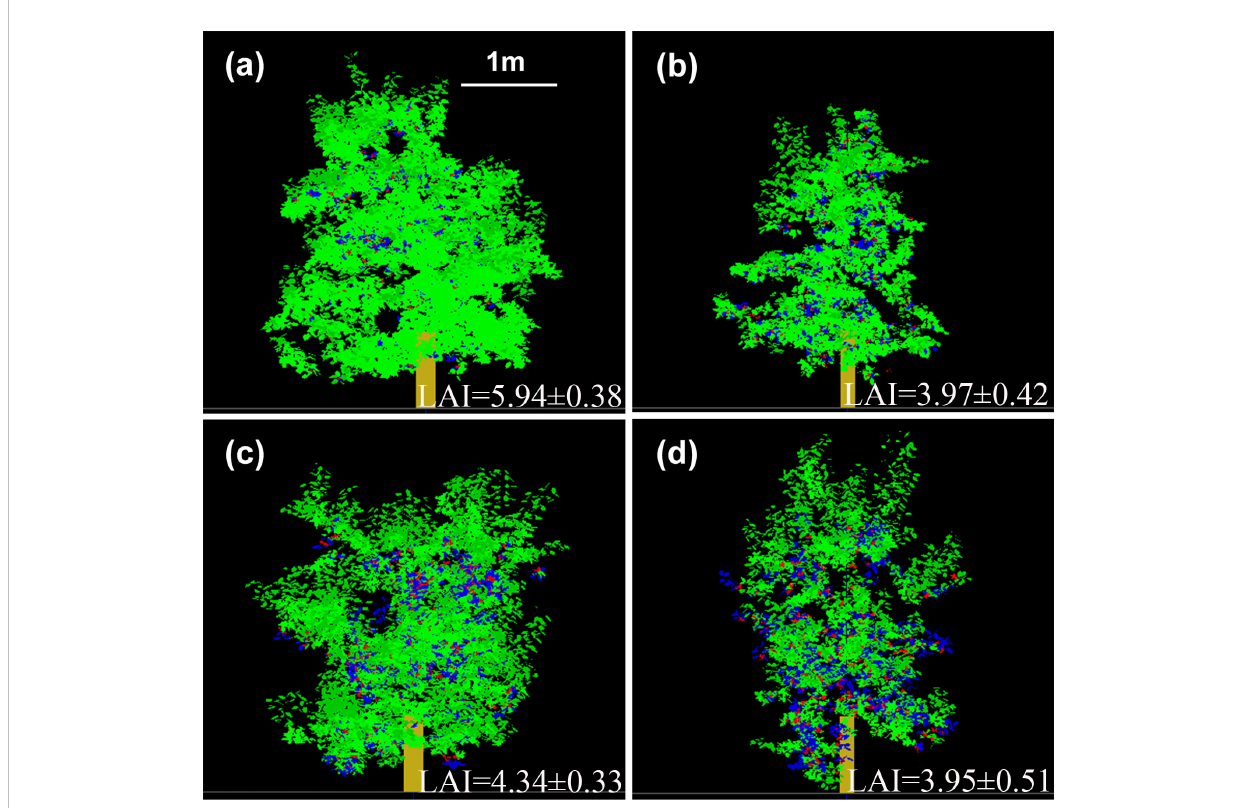
FIGURE 6 Three-dimensional representation of ‘ Fuji ’ (A, B) and ‘ Gala ’ (C, D) trees grafted on vigorous rootstocks associated with either a dwarf M26 interstock (VD, (B, D) or a vigorous ‘ Qinguan ’ interstock (VV, (A, C) . Leaf area index is given for each treatment. Virtual images were visualized with VegeSTAR